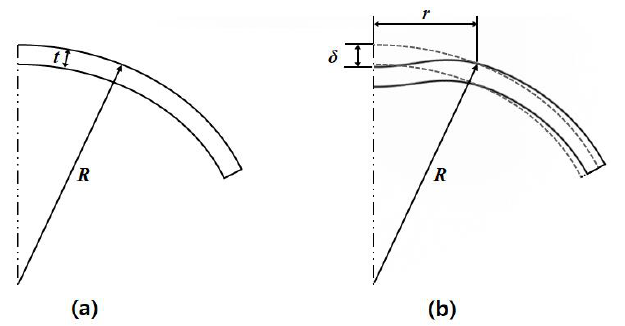
Figure 1. Schematic diagrams of ( a ) undeformed cornea apex and ( b ) deformed shape during application of acoustic radiation force.